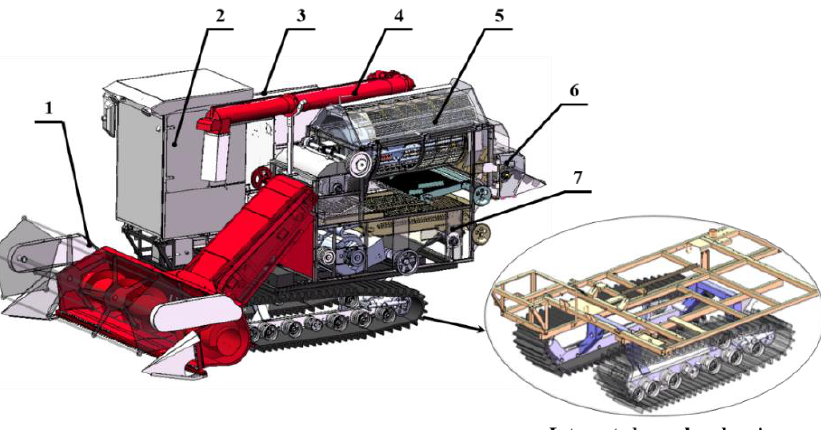
Figure 1. Schematic diagram of crawler combine harvester and welded integrated chassis. (1) header, (2) cab, (3) grain tank, (4) unloading device, (5) threshing device, (6) smashing device, (7) cleaning device.